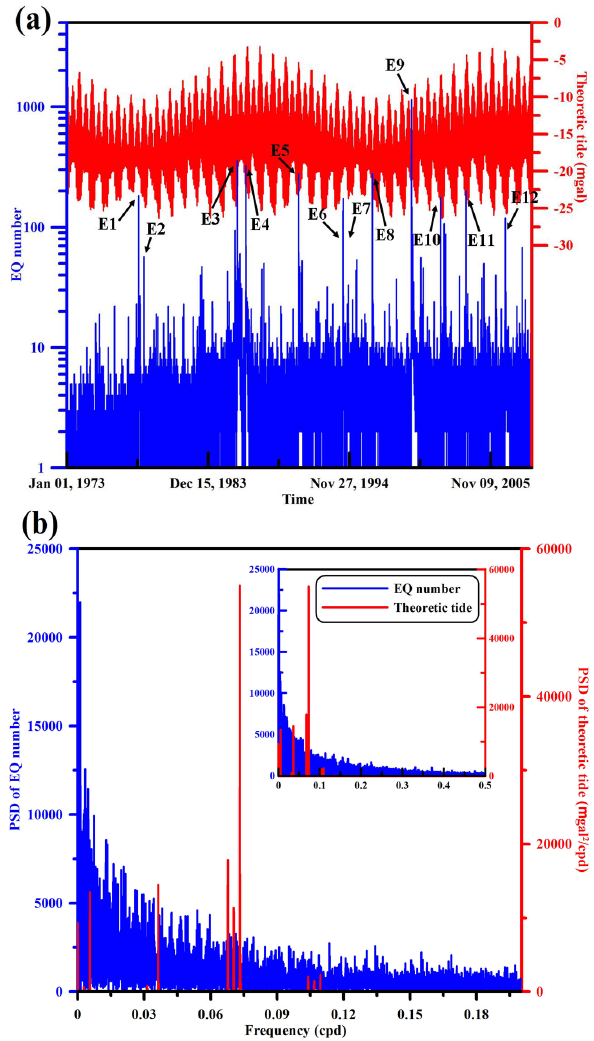
Fig. 2. (a) Time series of the number of daily earthquakes in Taiwan (blue) and theoretical Earth tides (red) calculated at the center of Taiwan; and (b) the Fourier power spectral density of time series of daily earthquakes and theoretical Earth tides. The symbols from E1 to E12 indicate large earthquakes in